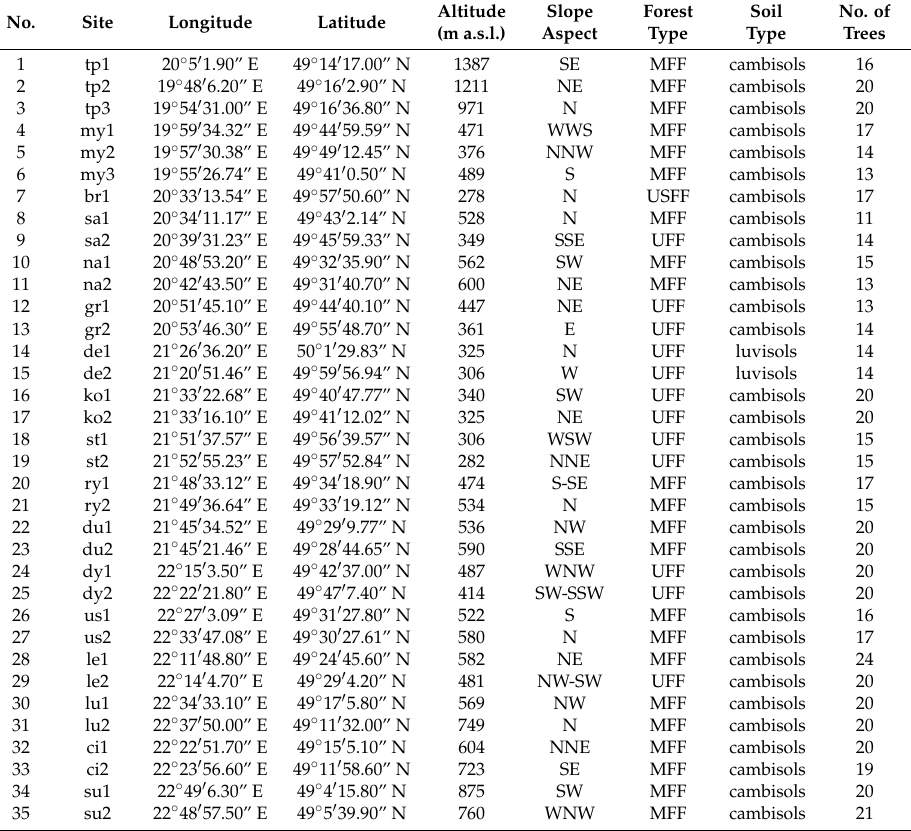
Table 1. Characteristics of the sampled